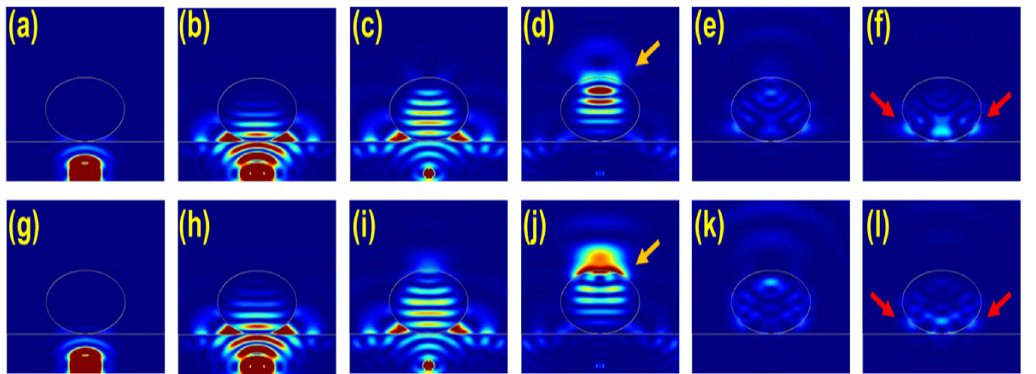
Figure 7. Evolution of travelling light via An-TiO 2 NSs ( a – f ) and Am-TiO 2 NSs ( g – l ) with respect to change of time. The red arrows represent the backscattering from the interface of air/TiO 2 sphere to p-GaN.